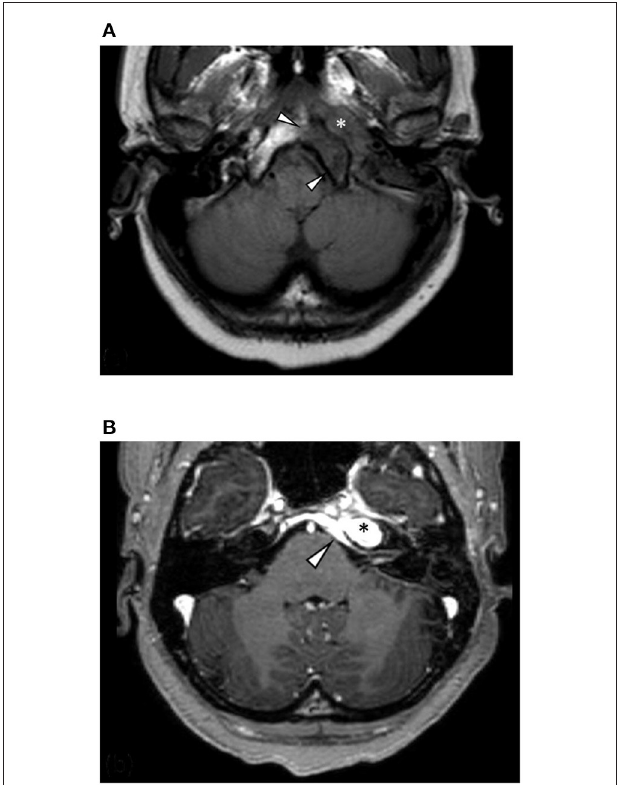
FIGURE 2 | (A) Axial T1-weighted MRI shows a hypointense mass centered on the left petrous apex (asterisk) and regional marrow hypointensity due to infiltration and marrow replacement (arrowheads). (B) Axial T1 following contrast administration shows avid homogenous enhancement of the lesion (asterisk) and intracranial disease extension with pachymeningeal enhancement and thickening of the retroclival dura (arrowhead).